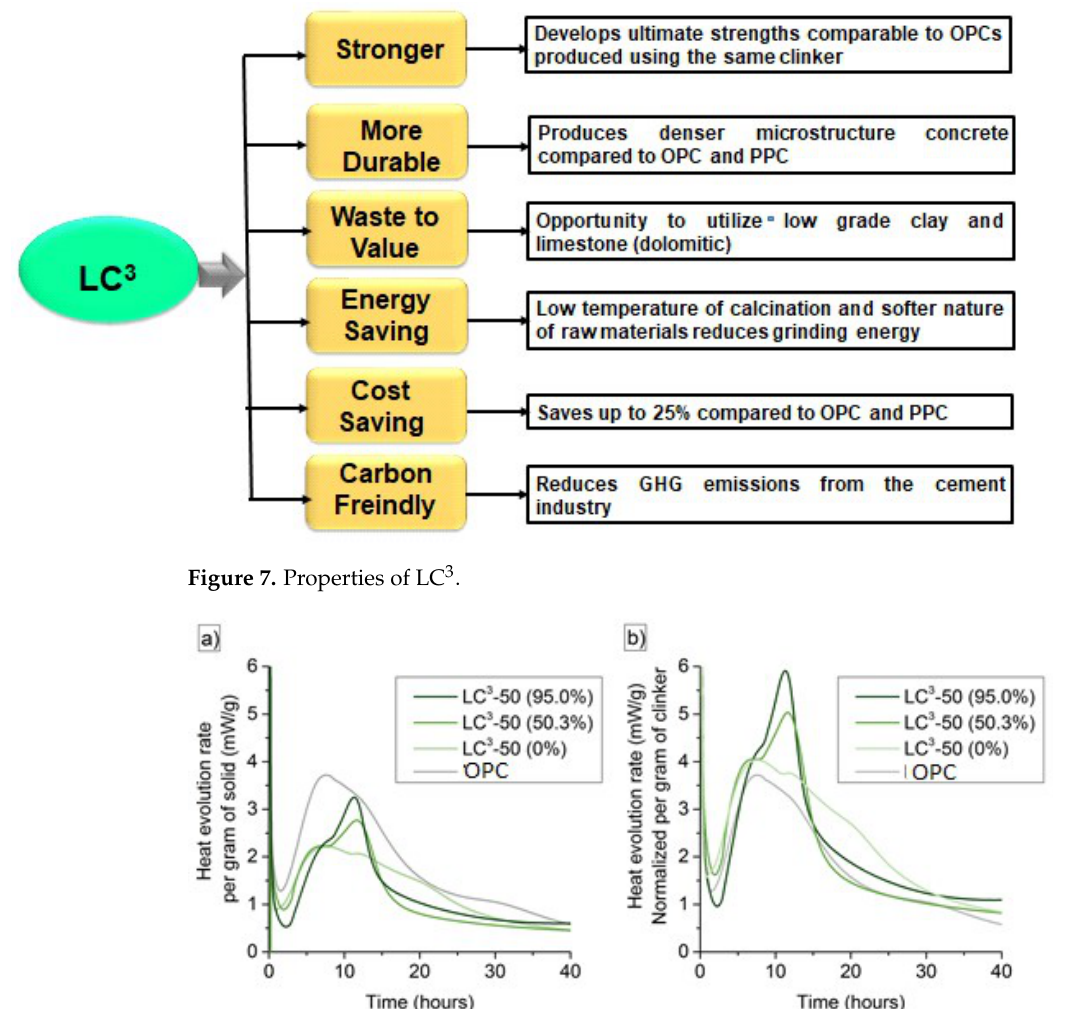
Figure 6. Preparation of LC 3 by blending different constituents.